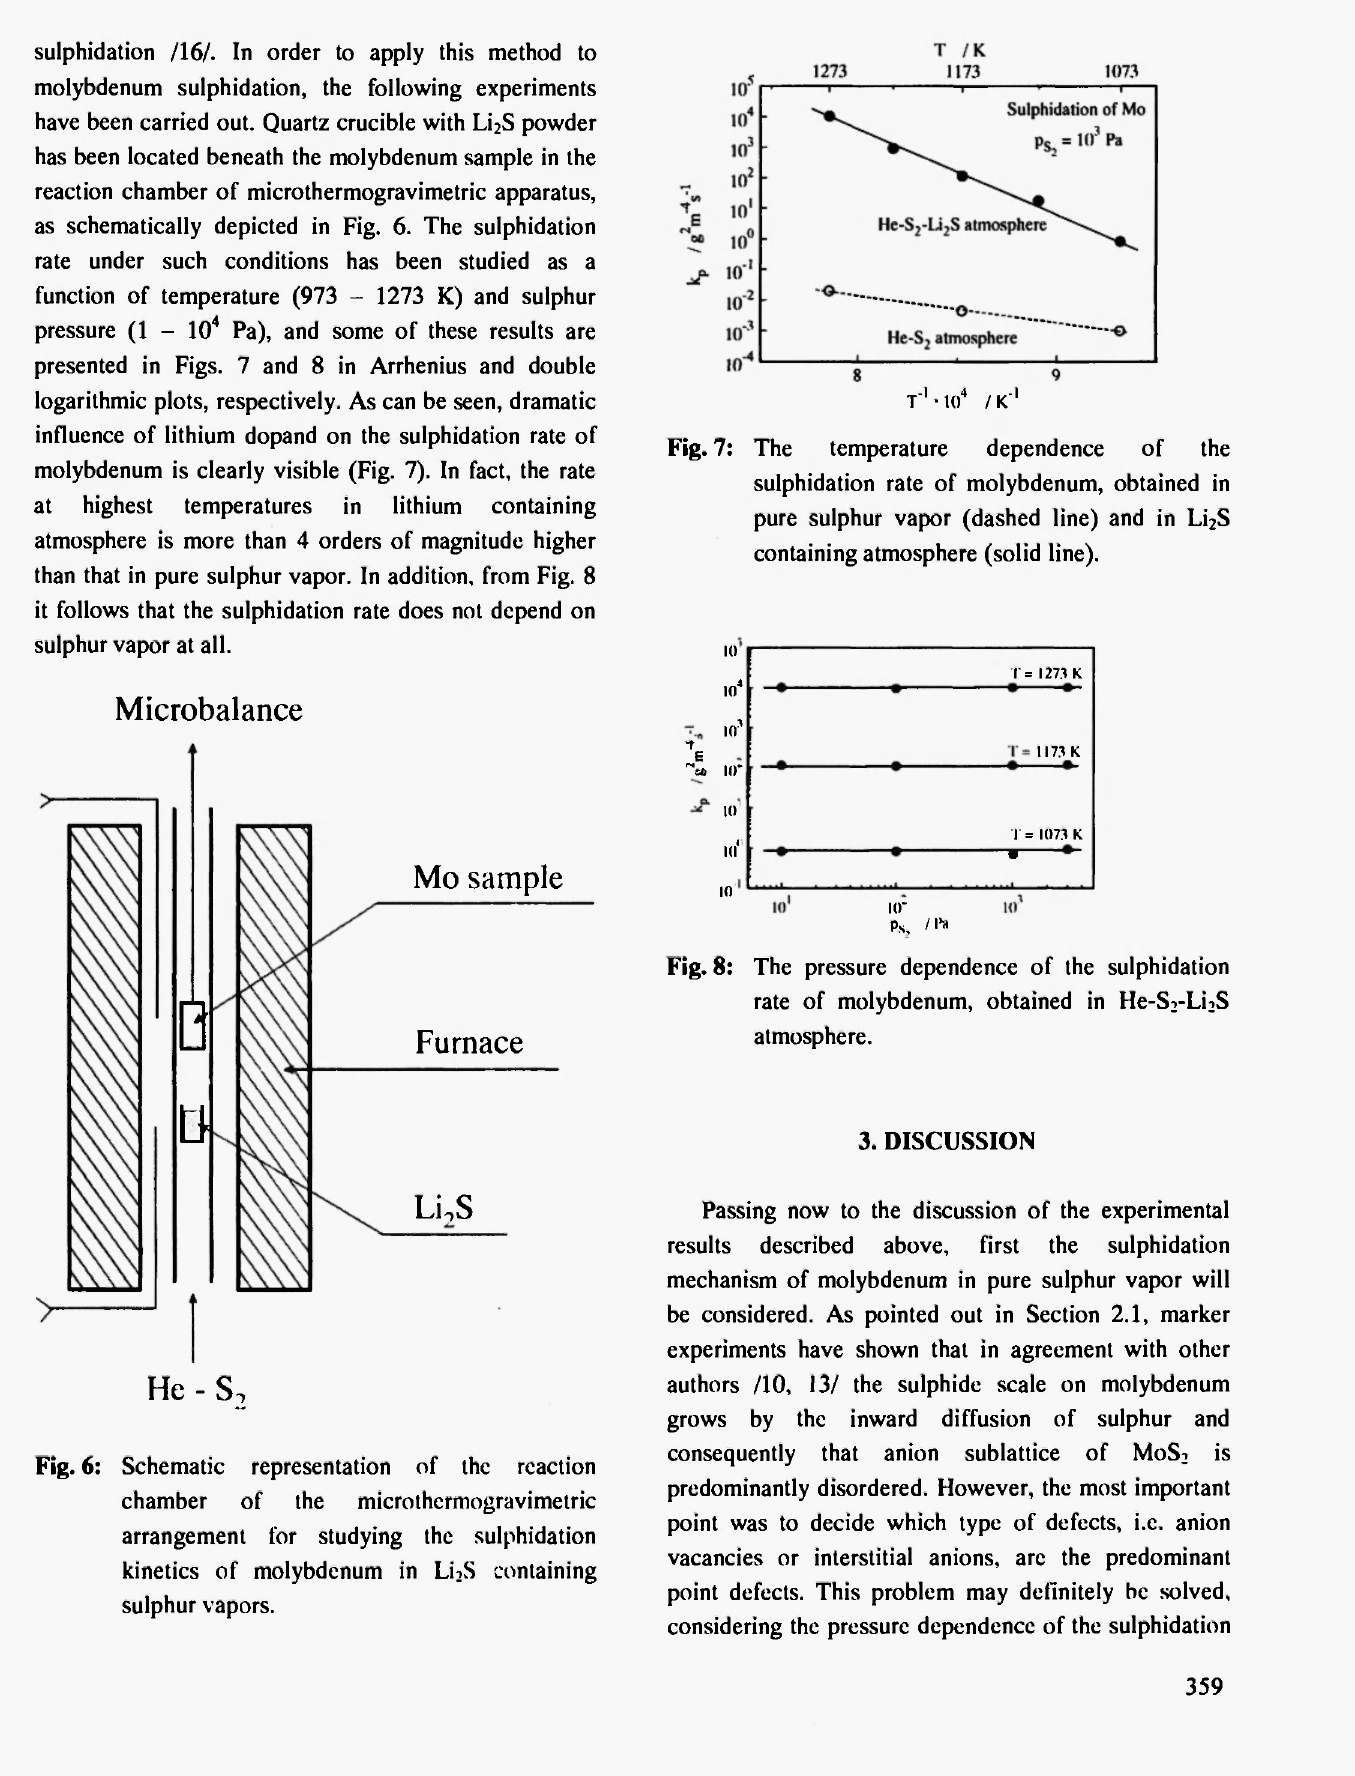
Fig. 6: Schematic representation of the reaction chamber of the microthermogravimetric arrangement for studying the sulphidation kinetics of molybdenum in Li 2 S containing sulphur vapors.